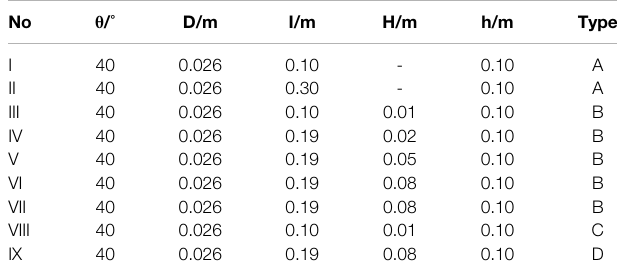
FIGURE 1 | Counter current fl ow in the hot leg during the condensate fl ow back.